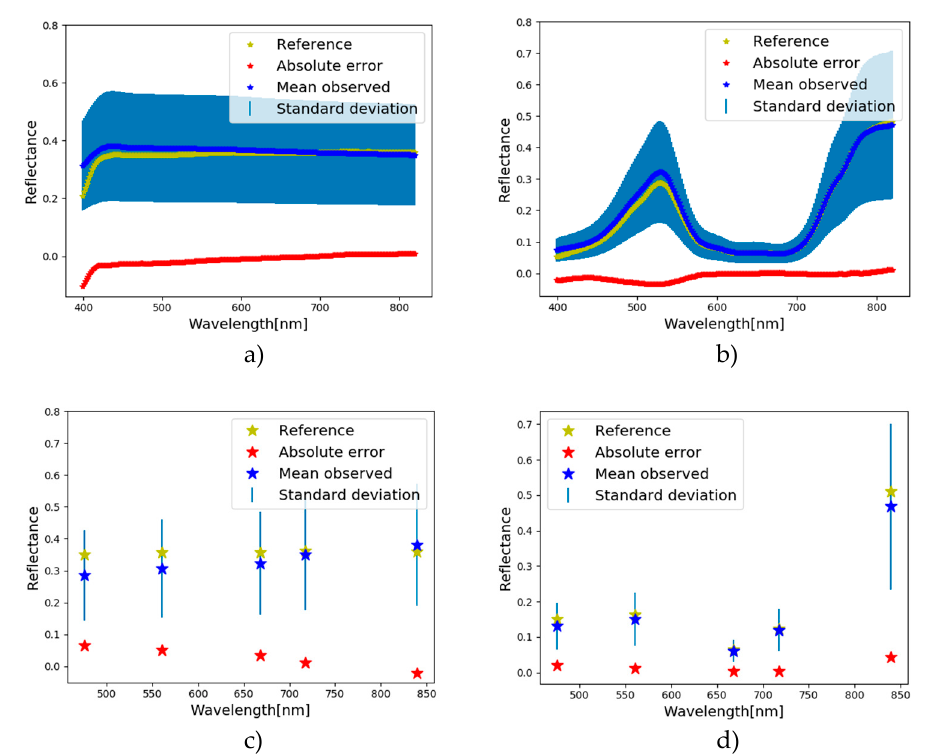
Figure 6. Data quality plots for the acquired imagery: top ( a , b )—hyperspectral data; bottom ( c , d )— multispectral data; left ( a , c )—grey tarp; right ( b , d )—green tarp.